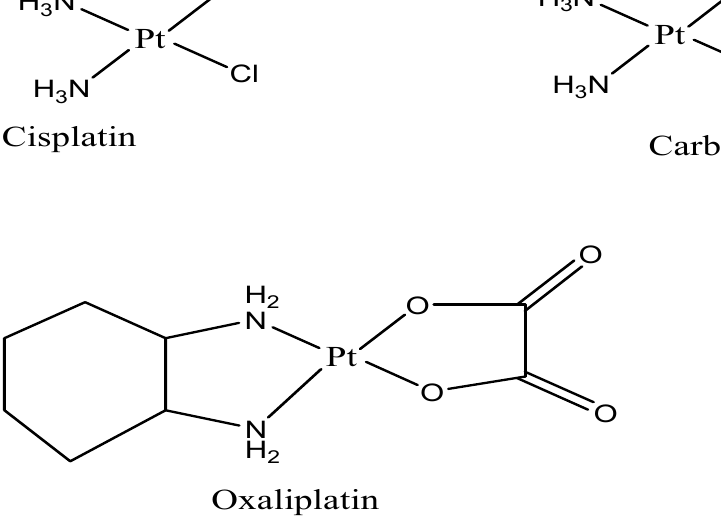
Figure 1. Approved platinum drugs in clinical use.